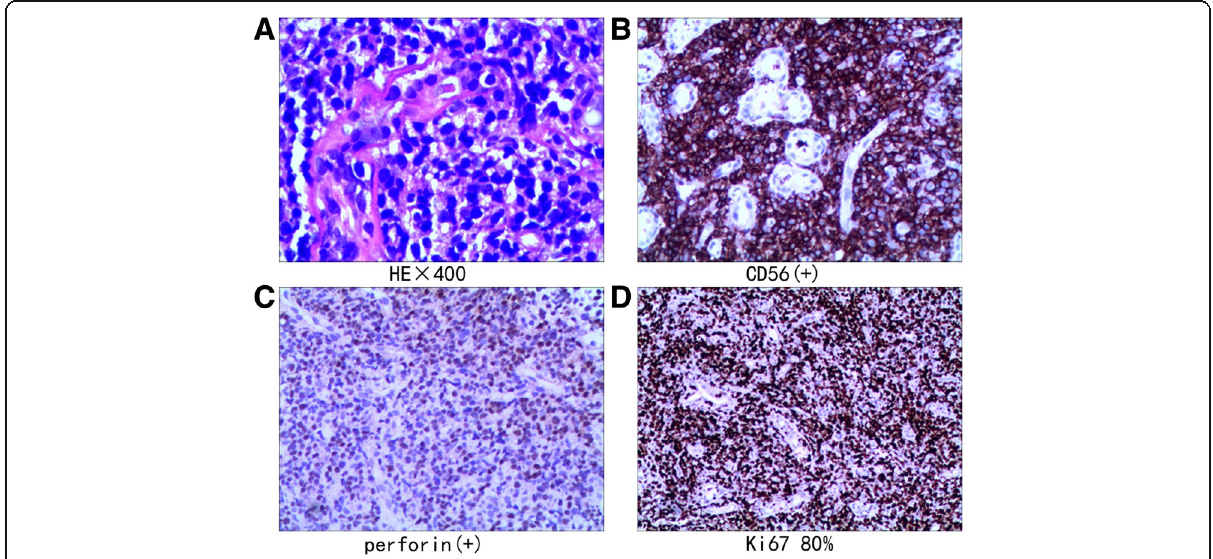
Fig. 3 The pathological findings of the tissue. a HE staining, ×400. The tissue was identified as nasal mucosa and coagulative necrosis with infiltrating monomorphic medium-sized lymphoid cells. b , c , d Immunohistochemically, the neoplastic cells were CD56+ and perforin+, and is approximately 80% of the cells were